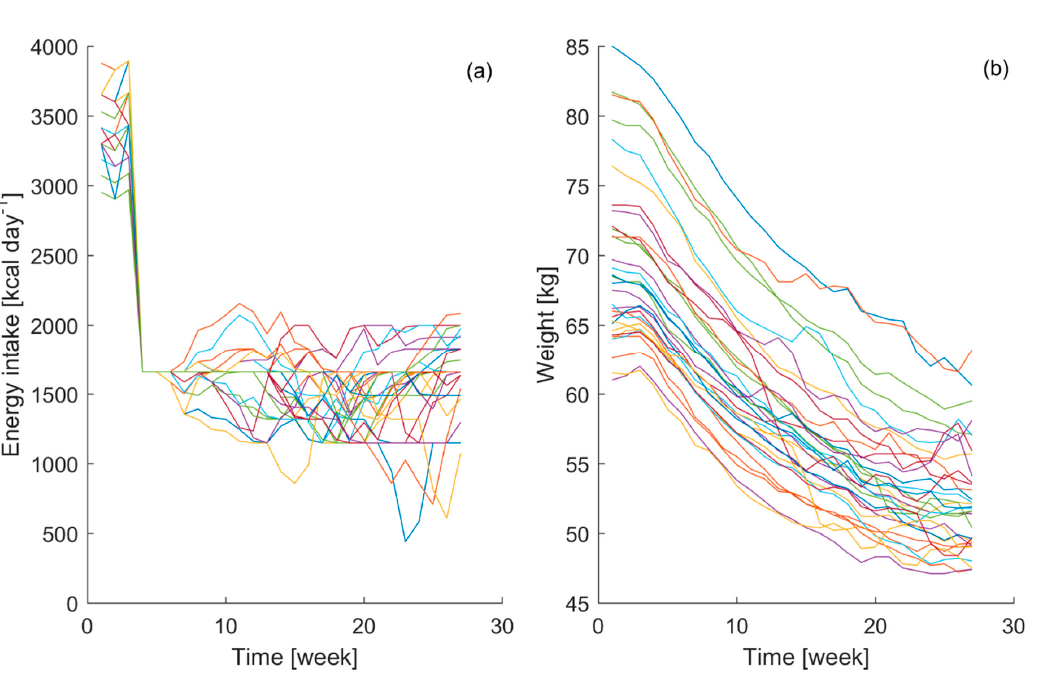
Table 1. Average Young information criterion ( YIC ) and coefficient of determination, 𝑅 (cid:3021) (cid:2870) , together with their standard deviation, obtained during the system identification process for each of the 32 sub-datasets created from the Minnesota starvation excel spreadsheet used in the work of [31]. [ n a n b